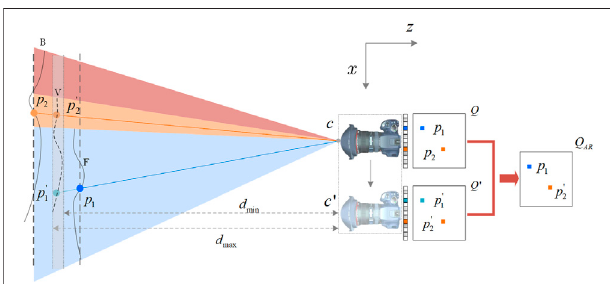
FIGURE 2 | Correspondence between pixels and points in optical fi eld